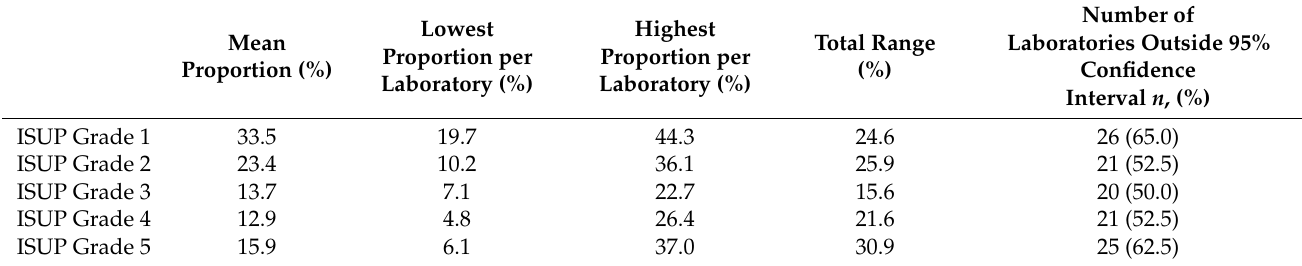
Table 2. Variation in ISUP Grade of patients in a nationwide Dutch cohort of prostate cancer patients in 40 laboratories.